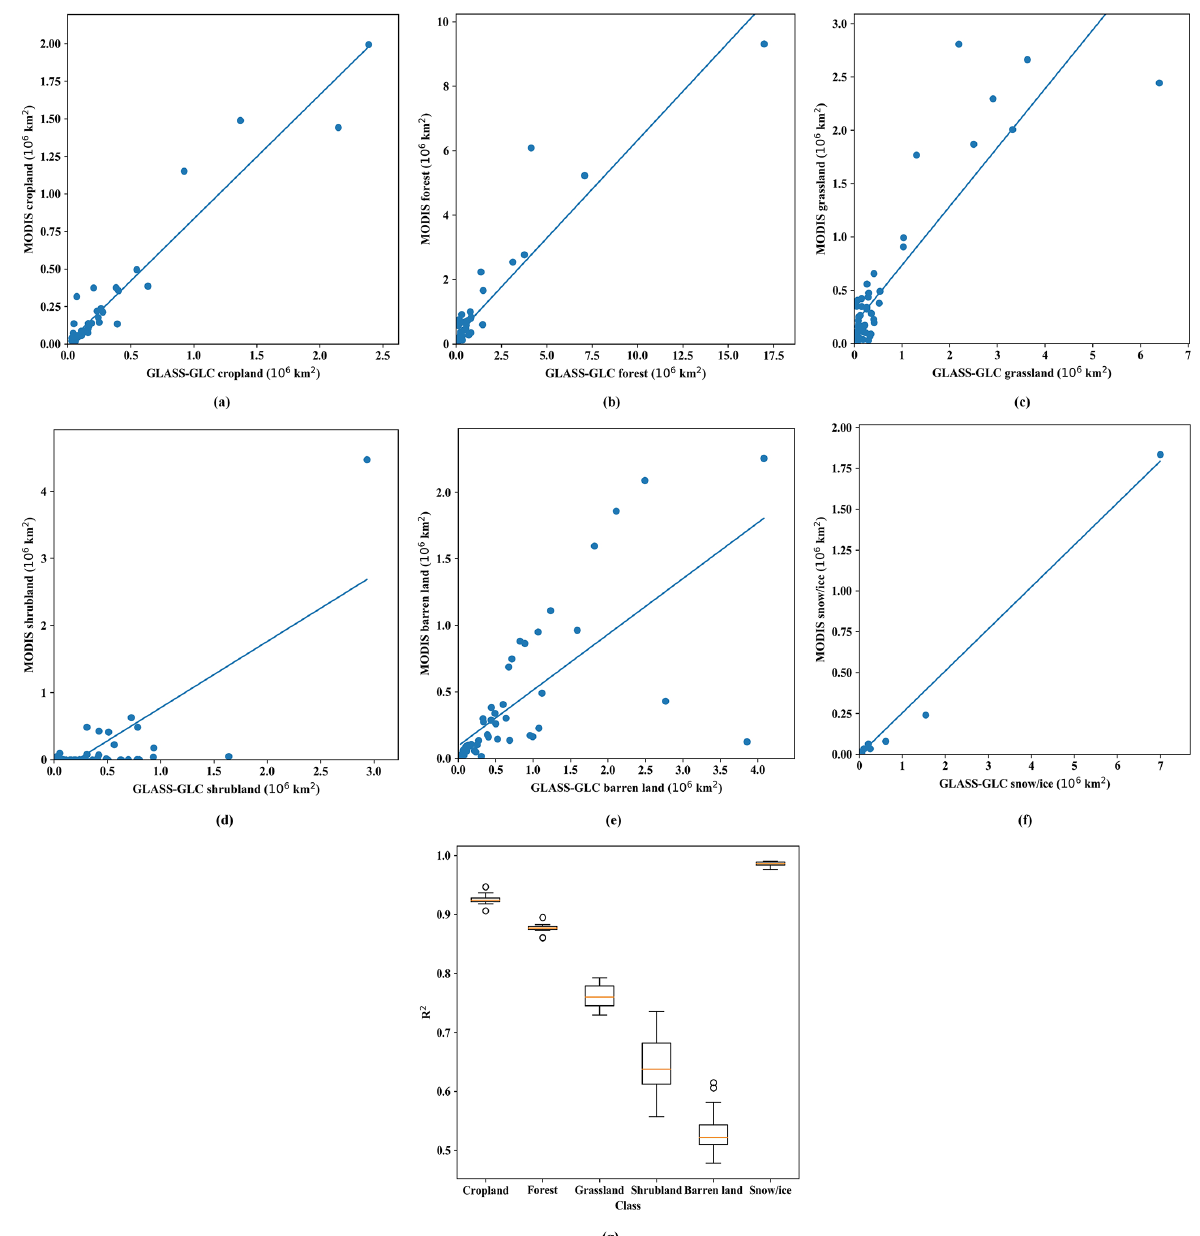
Figure 5. Intercomparison with the MLCT (MODIS Land Cover Type) product: (a) cropland circa 2015, (b) forest circa 2015, (c) grassland circa 2015, (d) shrubland circa 2015, (e) barren land circa 2015 and (f) snow/ice circa 2015; (g) mean R 2 of the annual linear fit lines for all years